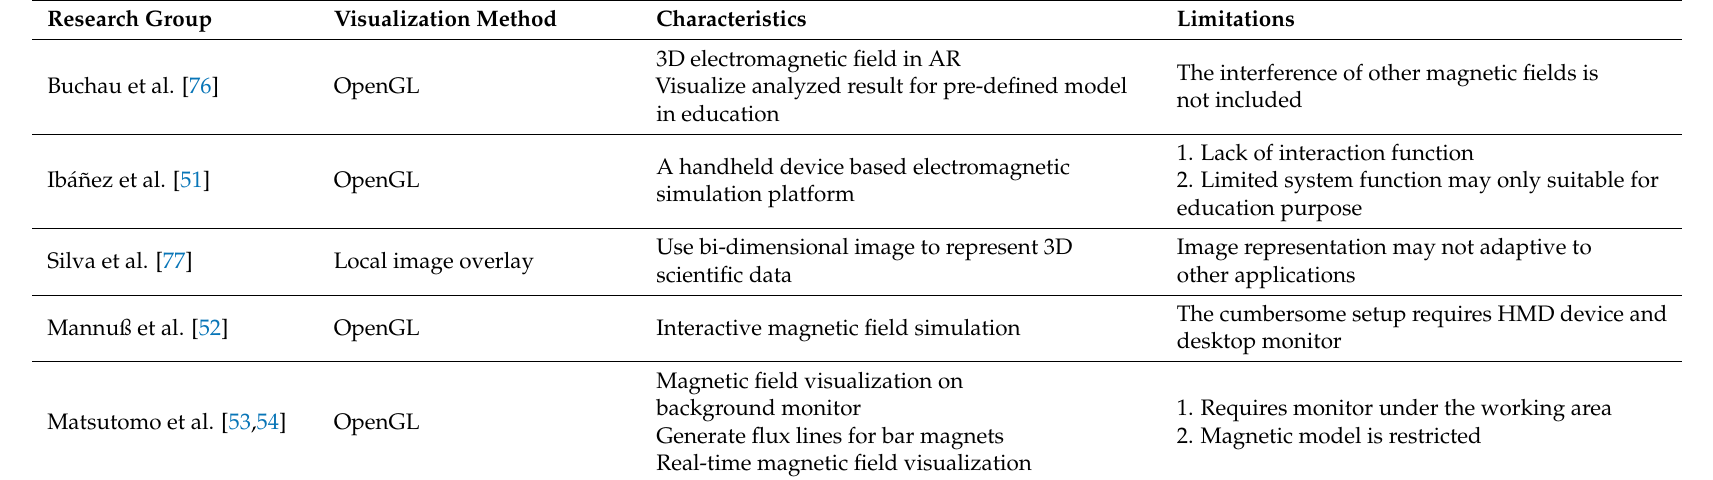
Table 5. Characteristics and limitations of research in